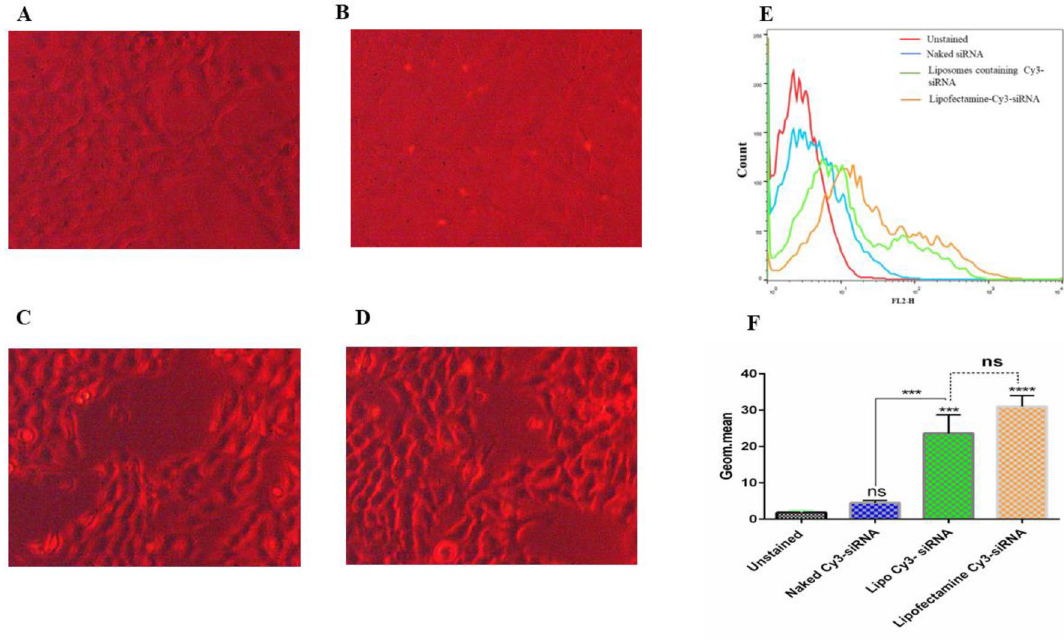
Figure 3. Uptake assay of liposomes containing Cy3-siRNA and Lipofectamine Cy3-CD73 siRNA in the 4T1 cancer cells. ( A ) The untreated 4T1 cells. ( B ) Un-liposomal Cy3-siRNA (Naked Cy3-CD73 siRNA). ( C ) Liposomes containing Cy3-siRNA. ( D ) lipofectamine Cy3-siRNA transfected cells. ( E ) The histogram analysis of siRNA uptake in 4T1 cells with liposome and lipofectamine compared to Naked siRNA. ( F ) Geometric mean (geom. mean) analysis of Cy3-siRNA uptake in 4T1 cells with liposome and lipofectamine. Data are shown as mean ± standard deviation (n = 3). Statistically significant differences are represented as follows: *** P < 0.001, **** P < 0.0001. The images are taken at 40X